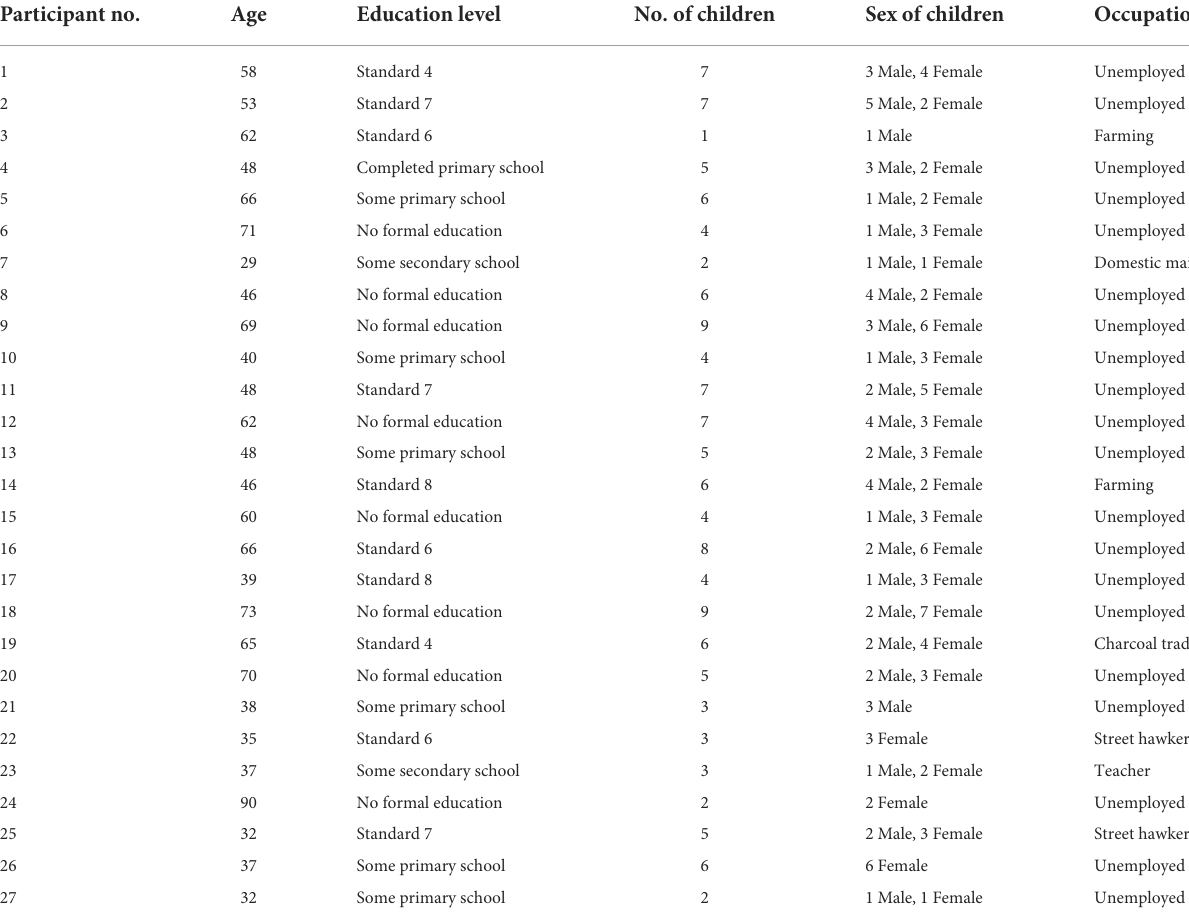
TABLE 1 Demographic description of the study participants. Participant